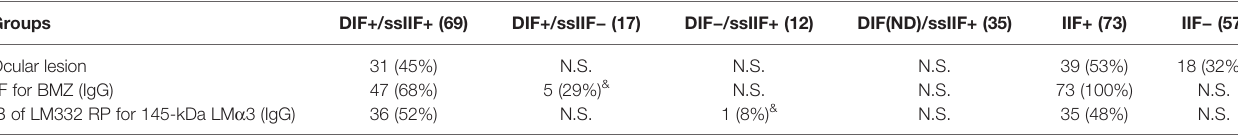
TABLE 5 | Comparisons among 4 DIF/ssIIF groups and 2 IIF groups. Groups